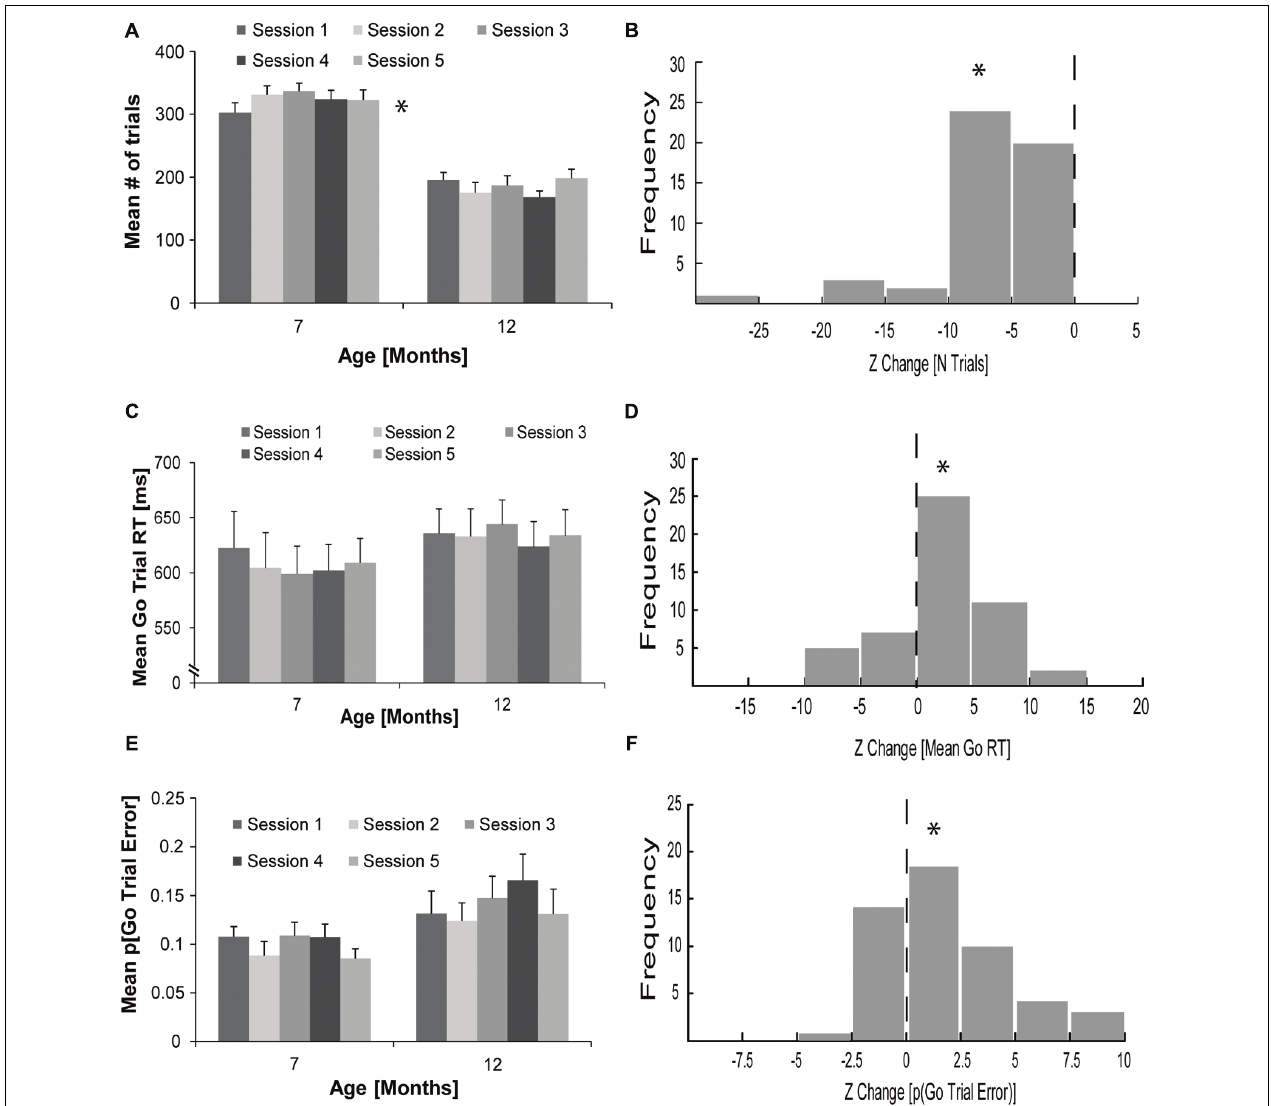
FIGURE 2 | Changes in countermanding task performance of rats with aging. (A) Mean ± standard error of the mean (SEM) total number of trials performed in five individual, 1-h countermanding task sessions (light–dark gray bars) for rats ( N = 10) at 7 and 12 months of age ( ∗ significant main effect of age with analysis of variance [ANOVA]). (B) Frequency distribution ( n = 50) for Z change in the total number of trials performed for rats ( N = 10) comparing the total number of trials performed in five individual sessions at 12 months of age to their overall mean total number of trials performed over five sessions at 7 months of age ( ∗ significant difference from zero, one-sample t -test). (C) Mean ( ± SEM) go trial RT in five individual countermanding task sessions (light–dark gray bars) for rats ( N = 10) at 7 and 12 months of age. (D) Frequency distribution ( n = 50) for the Z change in mean go trial RT for rats ( N = 10) comparing mean go trial RT in five individual sessions at 12 months of age to their overall mean go trial RT over five sessions at 7 months of age ( ∗ significant difference from zero, one-sample t -test). (E) Mean ( ± SEM) proportion of go trial errors (p[go trial error]) in five individual countermanding task sessions (light–dark gray bars) for rats ( N = 10) at 7 and 12 months